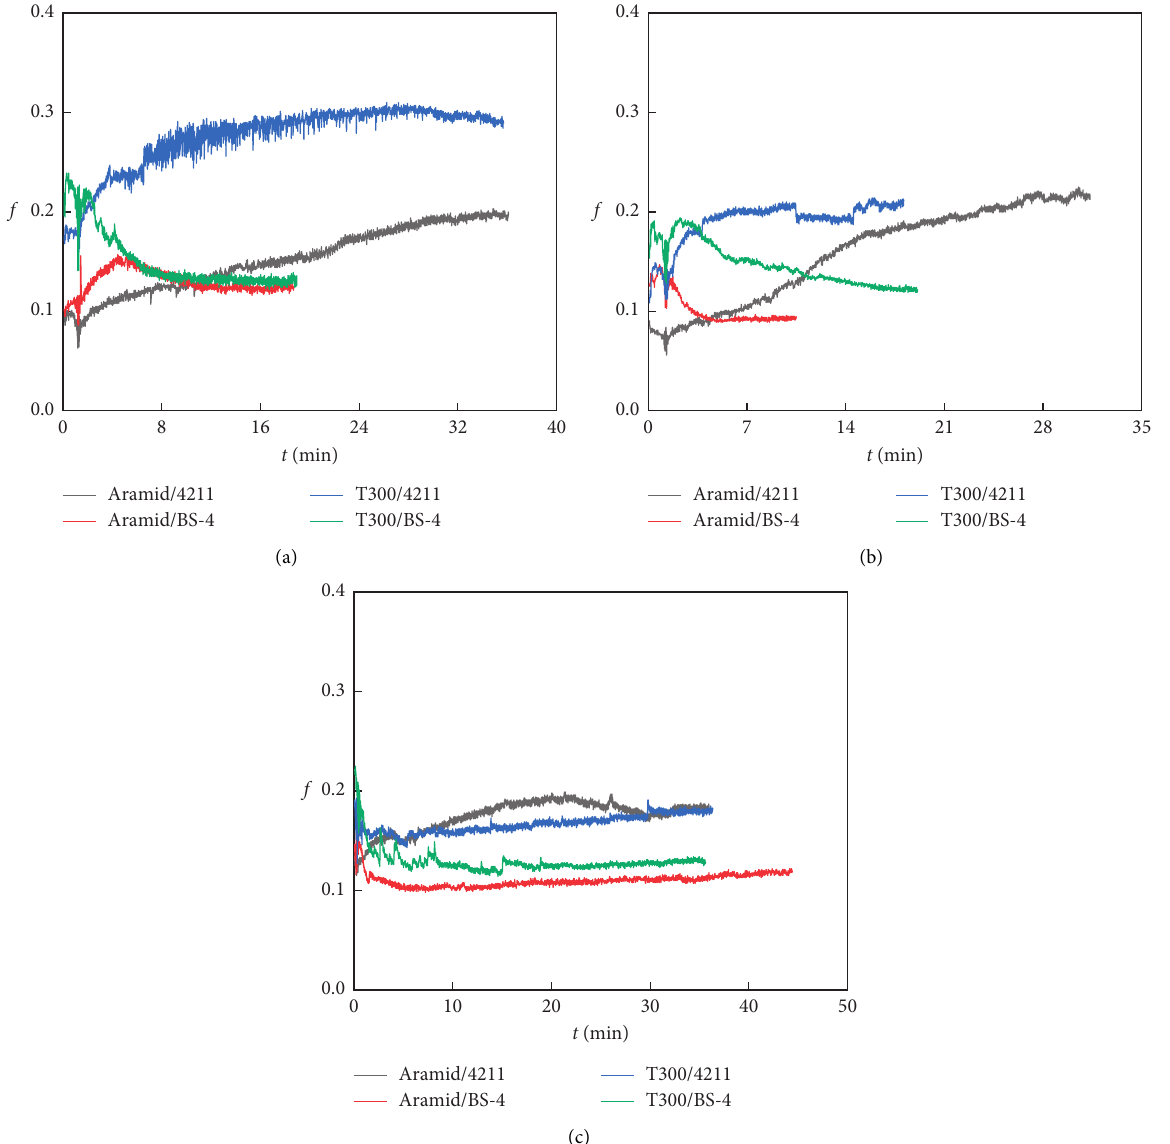
Figure 5: Friction coefficients of the composites coupled with 45 steel pins with (a) 50N, (b) 75N, and (c) 100N loads.